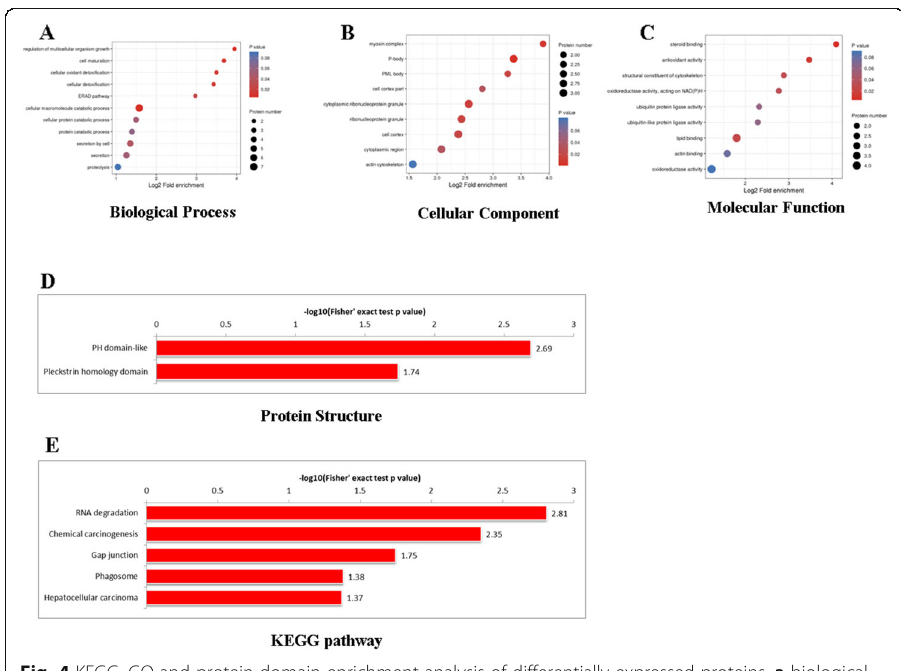
Fig. 4 KEGG, GO and protein domain enrichment analysis of differentially expressed proteins. a biological processes; b cellular components; c molecular functions; d protein domain; and e KEGG pathway enrichment. The functional classification or pathway is shown in the vertical axis of the bubble chart; the proportion of the differentially expressed protein in the functional type divided by the ratio of the identified proteins was converted using log2 and shown on the horizontal axis. The circle color indicates the enrichment P -value and the circle size indicates the number of differentially expressed proteins in the functional class or